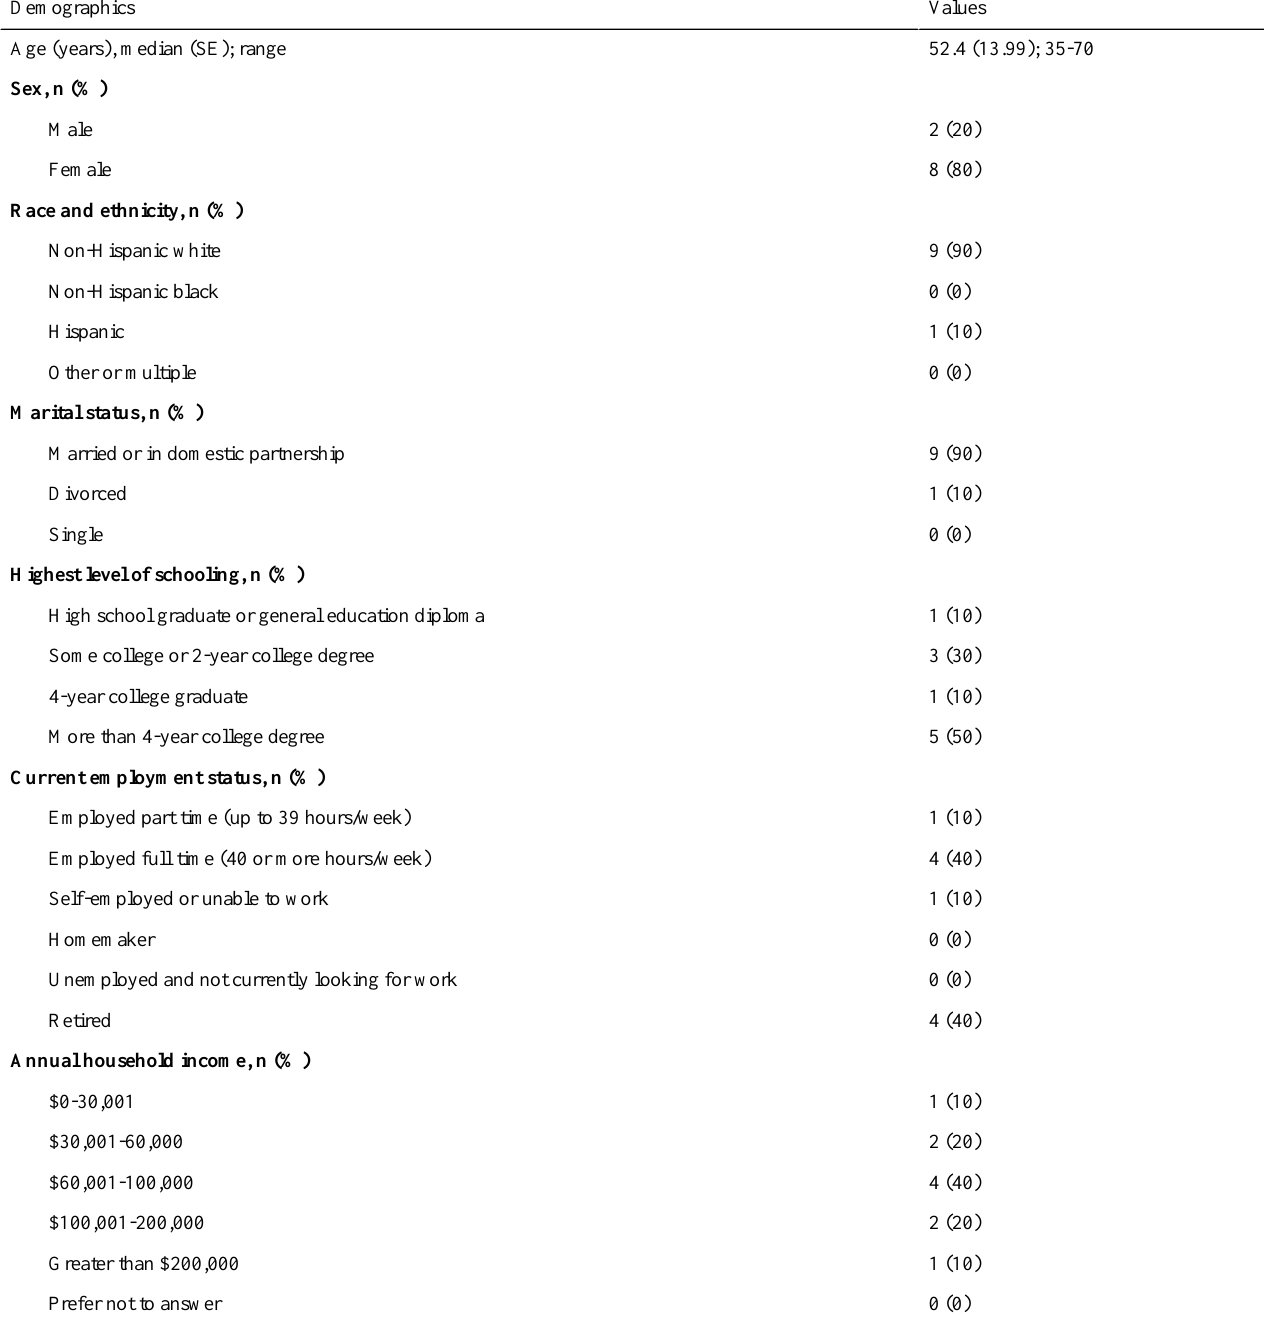
Table 1. Demographics of the study participants (N=10).